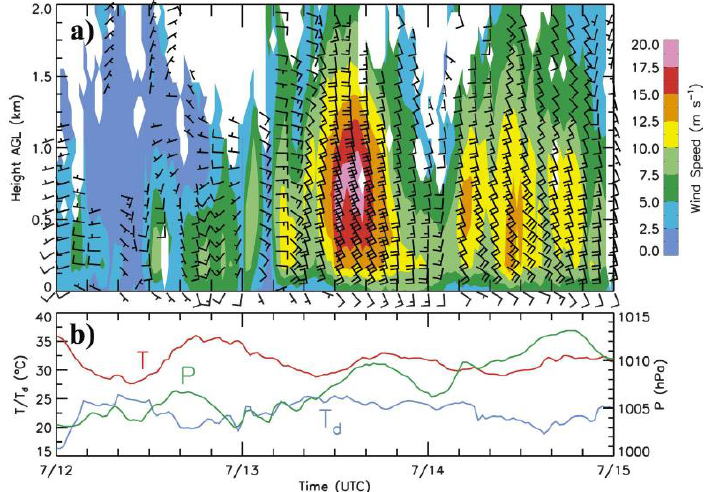
Figure 5. Puerto Peñasco ( a ) wind profiler and ( b ) surface data from 0000 UTC 12 July to 0000 UTC 15 July. In ( a ), wind speed (m s −1 ) is plotted every half-hour and wind barbs every 2 h. One full barb equals 5 m s −1 . Data not plotted for times and heights of low data confidence. In ( b ), surface temperature (°C, red), dewpoint temperature (°C, blue), and pressure (hPa, green) are averaged and plotted every half-hour. This figure is from [48], their Figure 4, © American Meteorological Society. Used with permission.